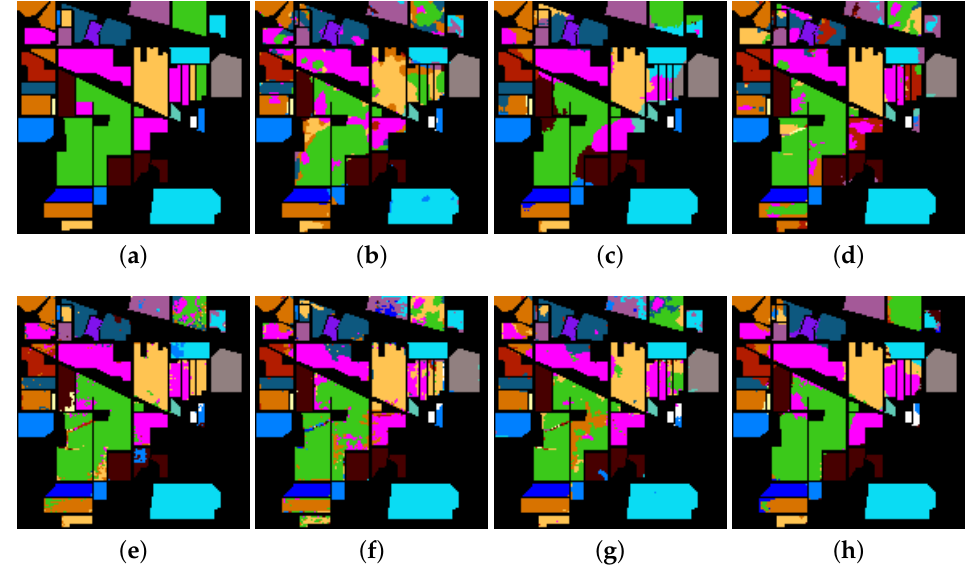
Figure 4. Classification maps by compared methods for Indian Pines data set. ( a ) The ground truth ( b ) GE ( c ) LGE ( d ) EPF ( e ) IIDF ( f ) RVCANet ( g ) HiFi ( h ) H 2